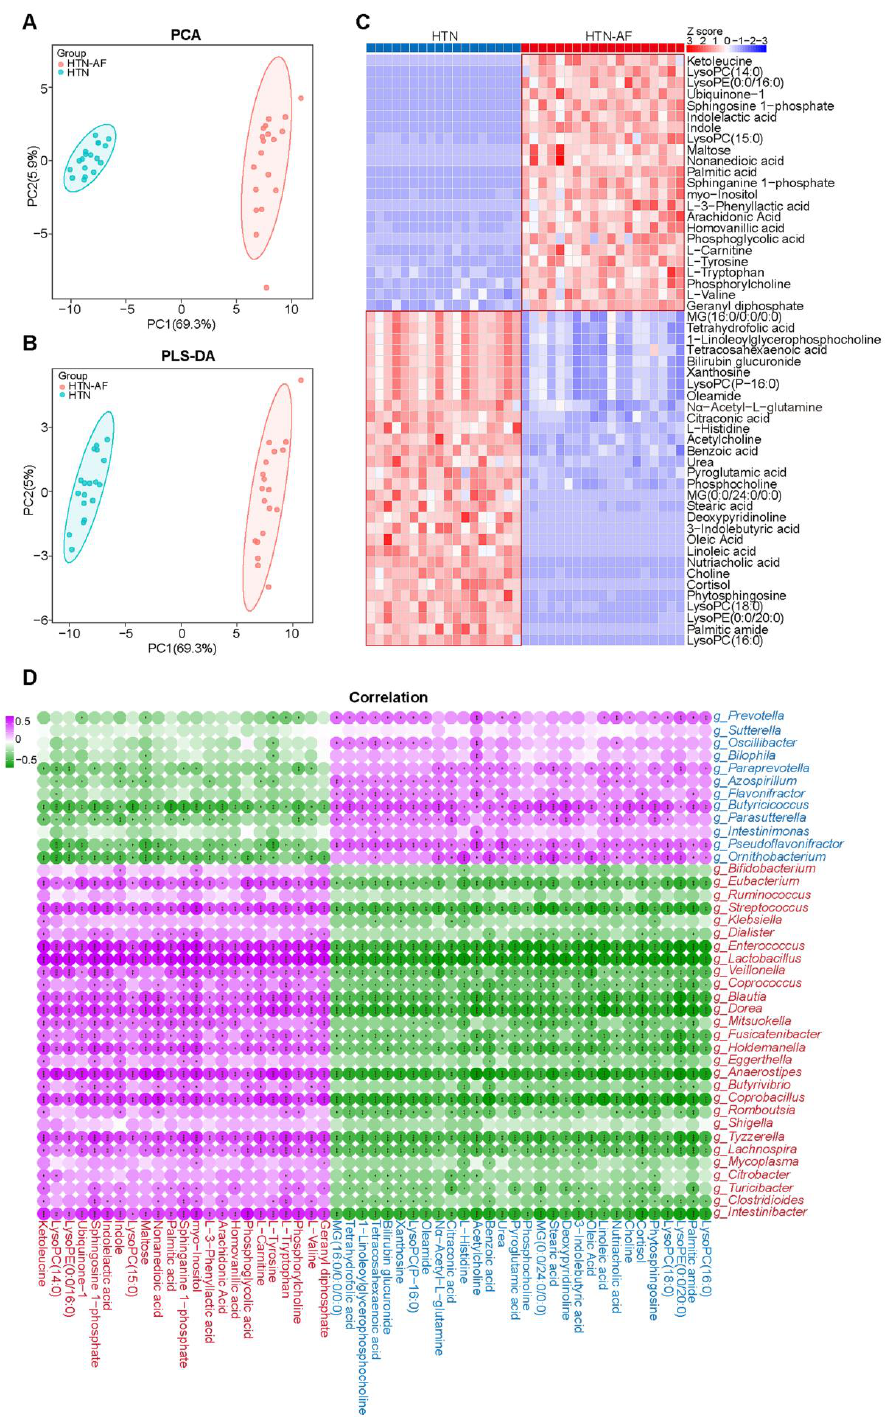
Figure 5. Altered metabolic signatures in HTN-AF patients. ( A , B ) PCA and PLS-DA score plots based on the serum metabolic profiles depicting the metabolic differences between HTN and HTN-AF groups. ( C ) Heat map describing the relative abundance of dramatically shifted serum metabolites in the two groups ( p < 0.05, VIP > 1). Abundance profiles were converted to Z-scores via average abundance subtraction and division by the standard deviation. Negative (blue) and positive (red) Z-scores reflected lower and higher row abundance levels than the mean, respectively. ( D ) Spearman’s correlation analysis revealed the correlation between altered genera and metabolites in the two groups. Purple, a positive correlation; green, a negative correlation; red, genera or metabolites enriched in HTN-AF group; blue, genera or metabolites enriched in HTN group; *, p < 0.05; **, p < 0.01; ***, p <